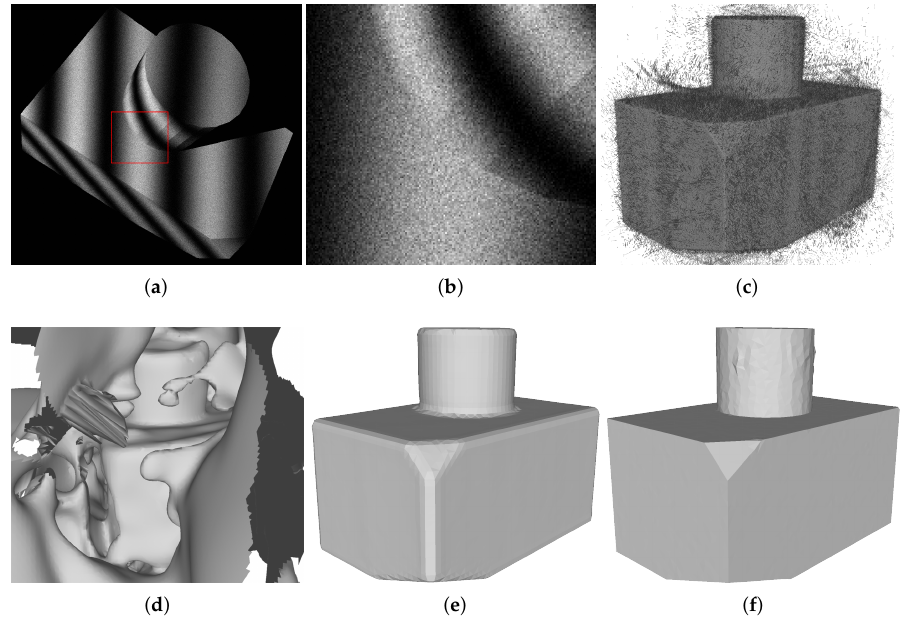
Figure 7. Our method can reconstruct meshes with sharp edges from very noisy images ( k = 10 3 ). Our method has a lower error ( ∆ V ) than a Screened Poisson reconstruction with a comparable number of ( k = 10 3 ). Our method had a lower error ( ∆ V ) than a Screened Poisson reconstruction with a vertices (spatial octree depth 7). The error of the RIMLS reconstruction could not be evaluated. comparable number of vertices (spatial octree depth 7). The error of the Robust Implicit Moving Least Squares (RIMLS) reconstruction could not be evaluated. ( a ) A noisy input image. ( b ) Crop of noisy image. ( c ) Point cloud. ( d ) RIMLS reconstruction [42]. ( e ) Poisson reconstruction [24] with 7064 vertices. ∆ V = 1.28%. ( f ) our method with 6038 vertices. ∆ V =